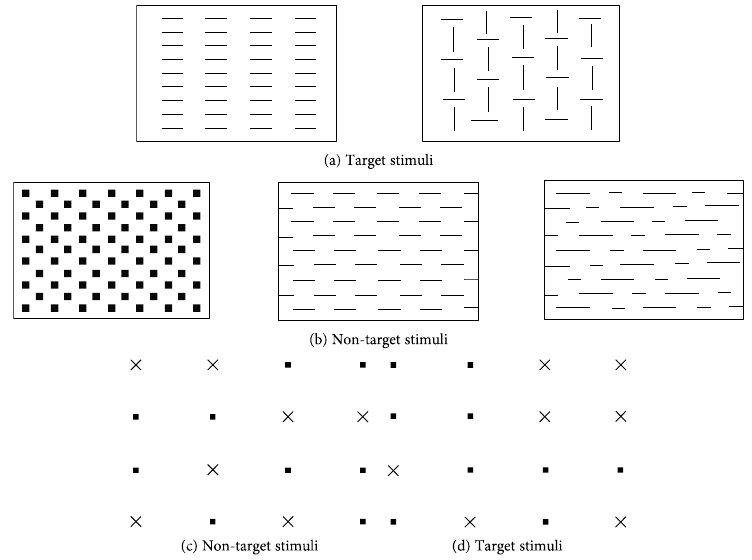
Figure 1. ( a , b ): Go / no go stimuli; ( c , d ): Non-target and target stimuli of divided attention